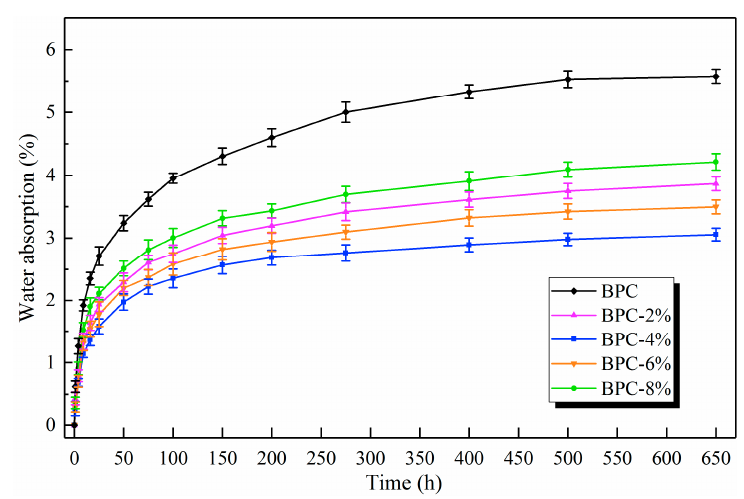
Figure 3. Water absorption curves of the BPCs.